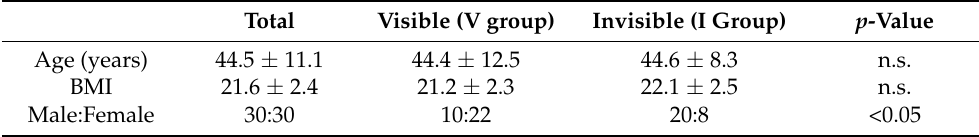
Table 4. Baseline demographic characteristics of patients. Total